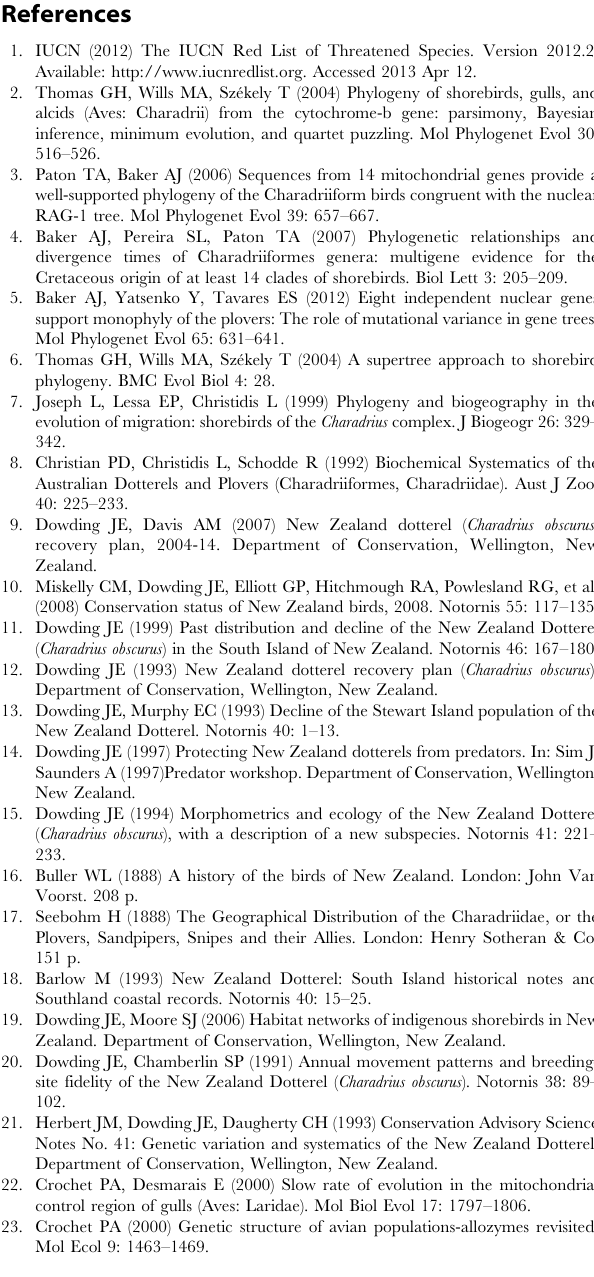
Figure S1 Bootstrap Support and Bayesian Posterior Probabilities for Garli, BEAST and MrBayes analyses. Illustration of topology differences between the three methods within the CRD II group. Table S1 All markers included in the study with GenBank/The Barcode of Life Database accession numbers. Table S2 Substitution models for each partition used in Garli and MrBayes phylogenetic